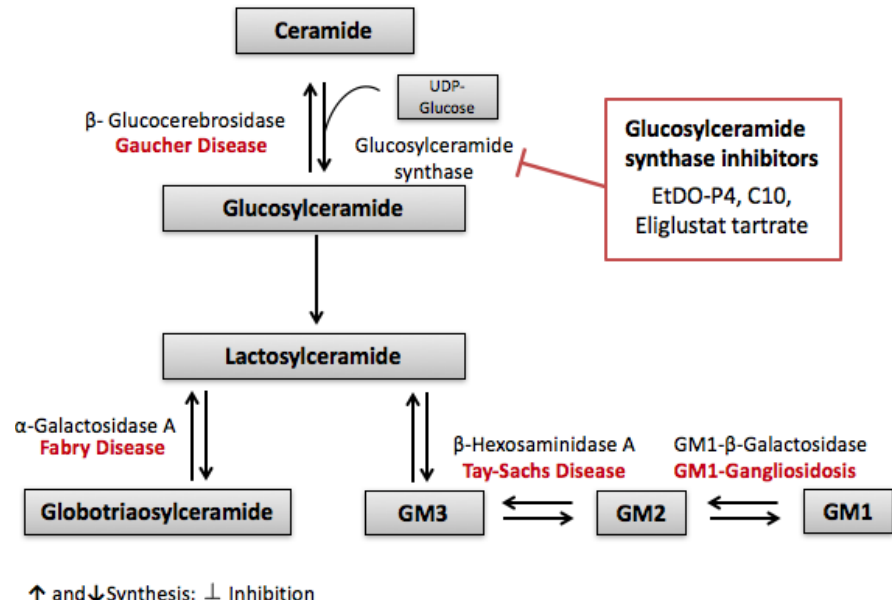
Figure 3. Substrate reduction theory: Glucosylceramide synthase inhibitors are therapeutic targets for lipid storing diseases. Glucosylceramide synthase inhibitors (EtDO-P4, C10 and Eliglustat tartrate) halt the synthesis of glucosylceramide, thereby preventing the downstream synthesis and accumulation of different sphingolipids involved in diseases such as Gaucher, Fabry’s, Tay-Sachs and GM1-Gangliosidosis.